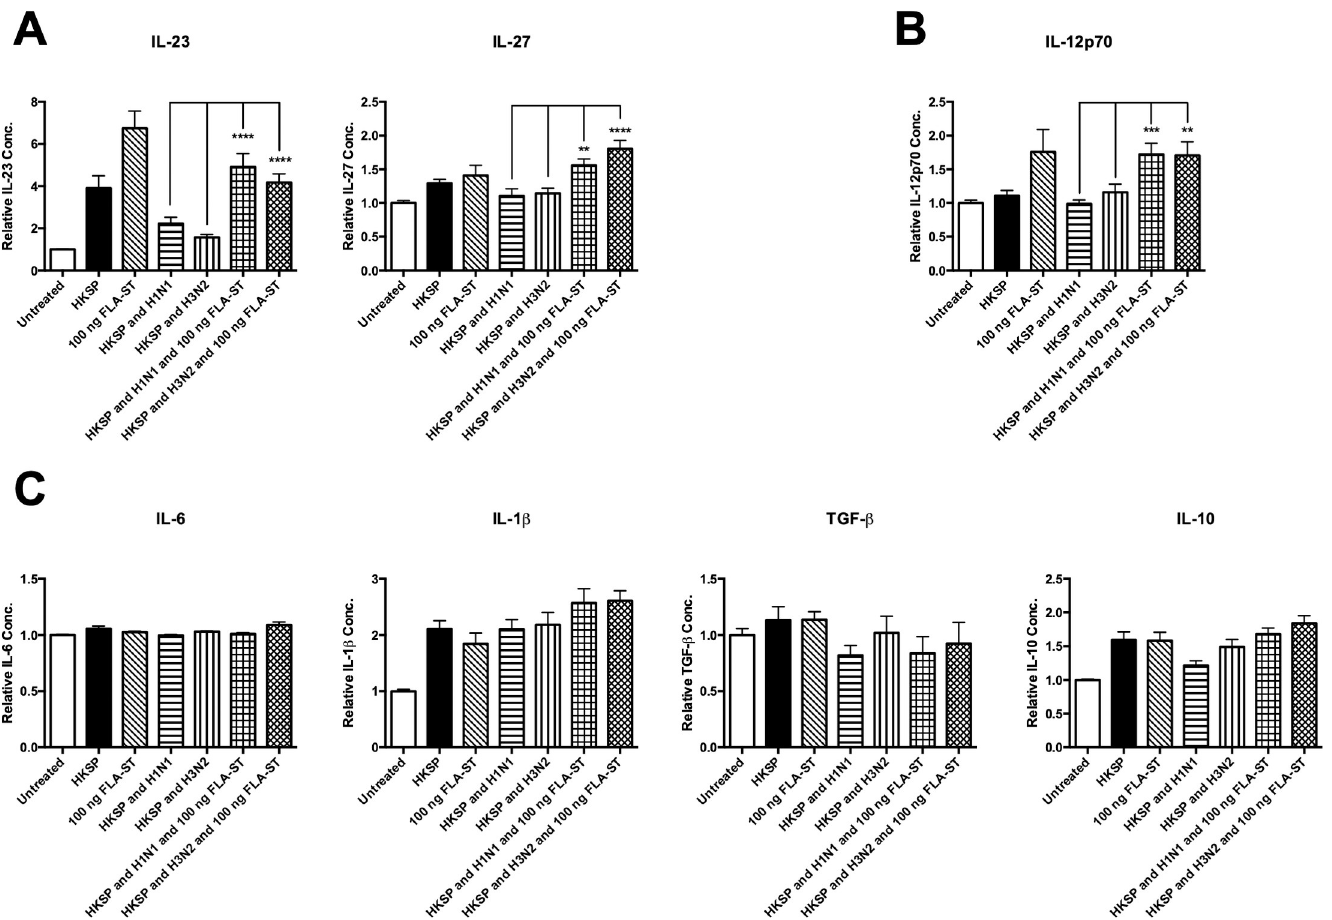
Fig 7. TLR5 agonism restores inhibited immune responses to S . pneumoniae during influenza infection in human monocytes. Levels of (A) IL-23, IL-27, (B) IL- 12p70, (C) IL-6, IL-1 β , TGF- β , and IL-10 secreted by CD14 + cells following 24 h treatment with HKSP, live H1N1 or H3N2 in combination with HKSP, live H1N1 or H3N2 in combination with HKSP and FLA-ST (or untreated as a control) were determined by ELISA. Each column represents normalised mean cytokine levels + SEM of 3 technical repeats of each treatment in every donor. Each ELISA represents normalised results from multiple donors (n): (A) IL-23 (n = 5), IL-27 (n = 5), (B) IL-12p70 (n = 5), (C) IL-6 (n = 5), IL-1 β (n = 5), TGF- β (n = 5), and IL-10 (n = 5). Statistical analyses were performed to compare cytokine levels in cells exposed to live H1N1 or H3N2 in combination with HKSP versus cells exposed to live H1N1 or H3N2 in combination with both HKSP and FLA-ST by fitting a One-Way ANOVA to the data and using a Sidak test to adjust for multiple testing ( �� p < 0.01, ��� p < 0.001, ���� p < 0.0001).